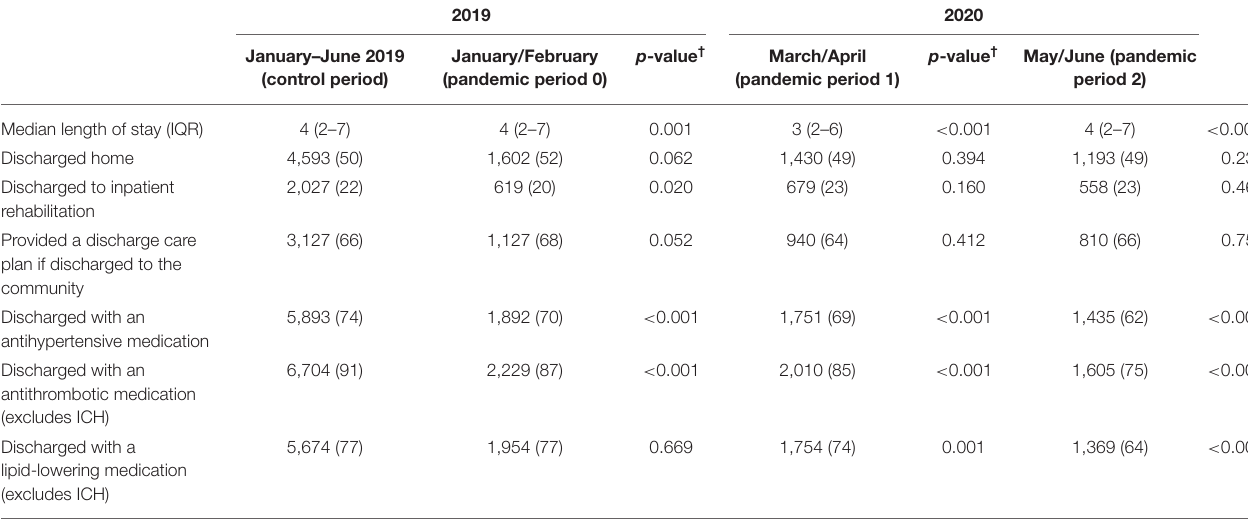
TABLE 2 | Comparison of discharge care and length of stay for the historical-control period and different stages of the pandemic in 2020.